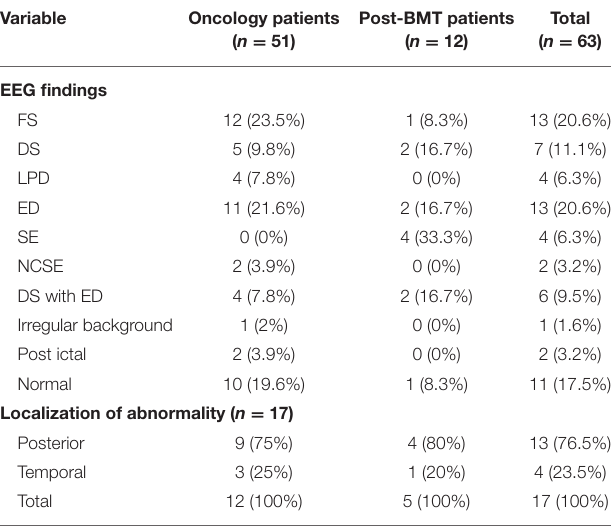
TABLE 4 | EEG findings of PRES between oncology and post-BMT patients.